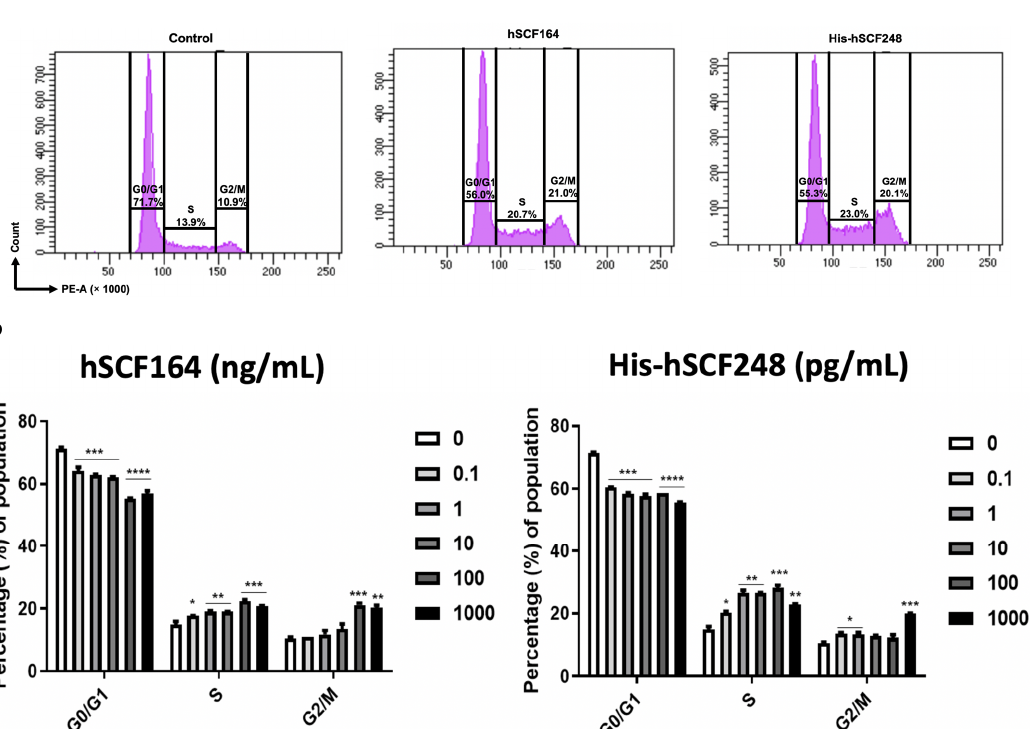
Figure 7. Flow cytometric analysis of cell cycle following treatment with hSCF. ( a ) Cell cycles of treated TF-1 cells were analyzed with FACS. The concentrations of hSCF164 and His-hSCF248 were 1 μg/mL and 1 ng/mL, respectively. ( b ) The relative percentages of cell cycle phase by hSCF164 and His-hSCF248 were dose-dependent. Note that the units of concentration for hSCF164 and His-hSCF248 were ng/mL and pg/mL, respectively. One-way ANOVA and Dunnett post hoc (* p < 0.05, ** p < 0.01, *** p < 0.001, **** p < 0.0001).